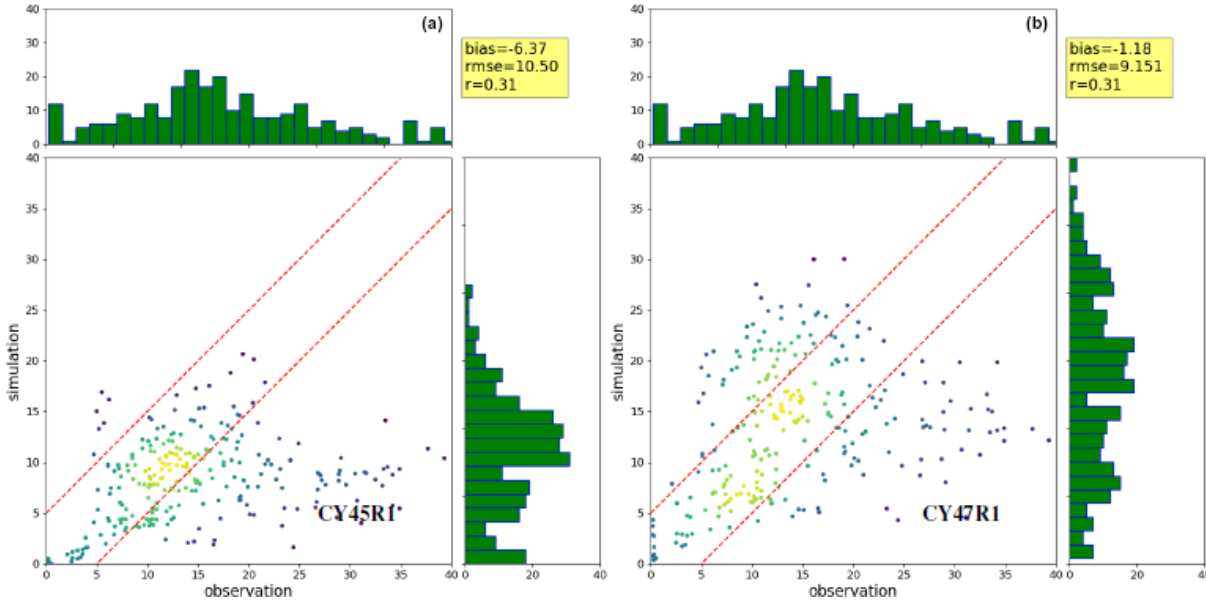
Figure 13. Density plot (for 2017) of monthly simulated ( a CY45R1, b CY47R1) sea salt surface concentration (in µgm − 3 ; sum of bin1 and bin2) vs. climatological values from 21 AEROCE/SEAREX